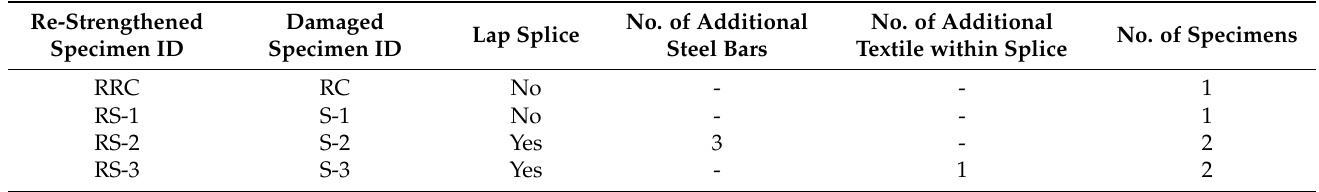
Table 8. Characteristic of re-strengthened slab specimens for flexural